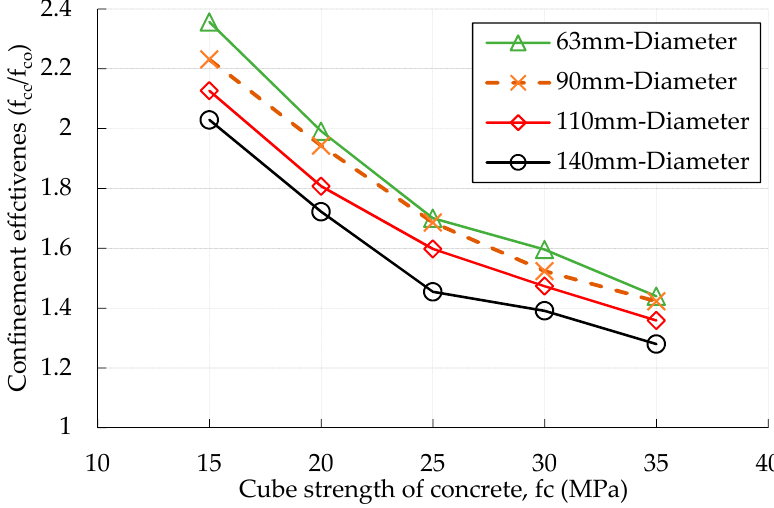
Figure 10. The e ff ectiveness of uPVC Figure 10. The effectiveness of uPVC confinement.